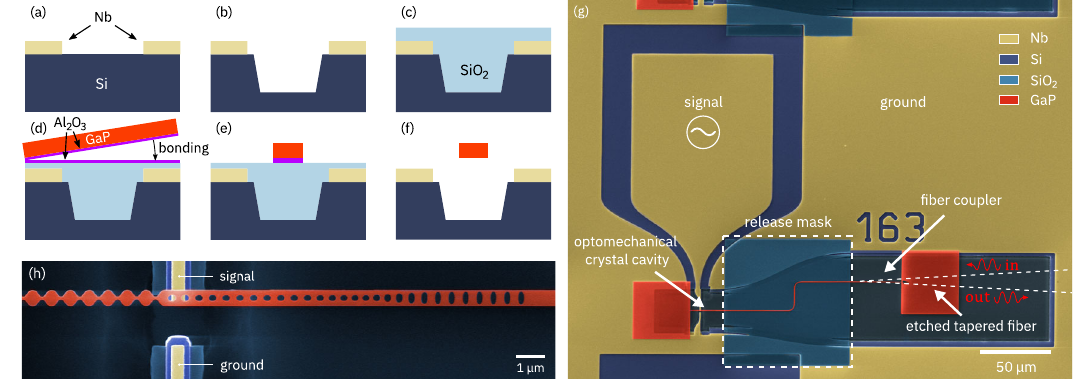
Fig. 2 Device fabrication process. a Deposition and patterning of Nb electrodes. b Local recessing of the Si substrate. c Deposition and planarization of the sacri fi cial SiO 2 layer. d Direct wafer bonding of the GaP device layer. e Patterning of the integrated GaP photonic circuit. f Release of the free-standing portion of the device. g False-color scanning electron microscope (SEM) image of the fi nished device with annotation of microwave and optical ports. h Close-up false-color SEM image of the optomechanical crystal